Question: In one sentence, what is this figure communicating?
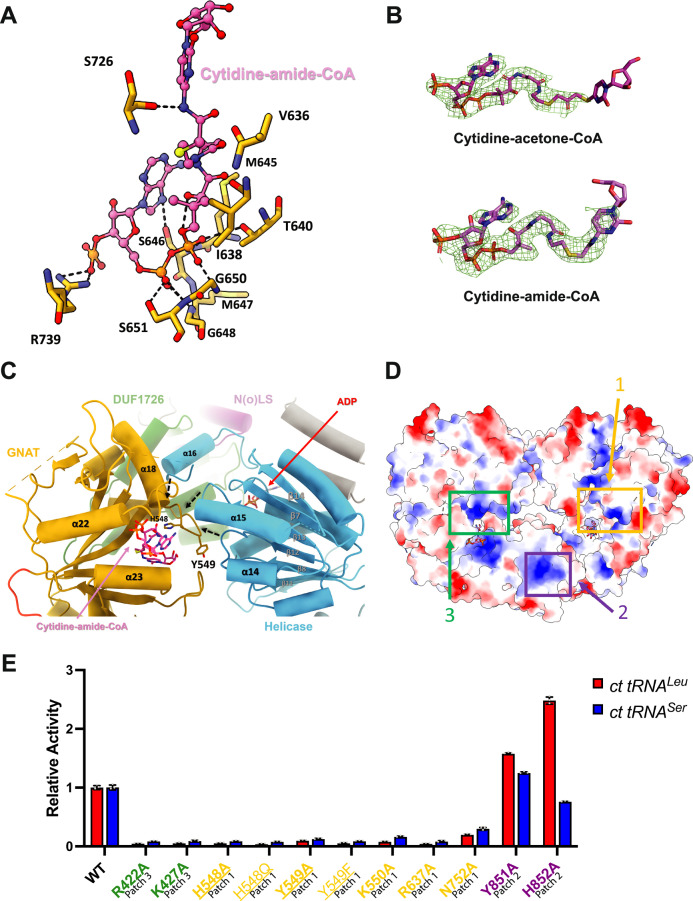
Answer: Acetyl-CoA, Cytidine and RNA binding sites of Ct NAT10. A Close-up view of interactions between Cytidine-amide-CoA and Ct NAT10 protein (figure derived from PDB: 9B0I). Cytidine-amide-CoA (pink) is drawn with ball-and-stick representation and labeled with the same color, and residues that make a hydrogen bond and with Cytidine-amide-CoA are shown by black-colored dashed lines. Van der Waals interaction and hydrophobic interaction are not explicitly shown but described in the main text. Atoms are color-coded as in Fig. 3 . B Cryo-EM density of Cytidine-acetone-CoA (figure derived from PDB: 9AYM) and Cytidine-amide-CoA (figure derived from PDB: 9B0I). Contour levels of 7 σ and 8 σ was shown, respectively. C Putative catalytic residues His548 and Tyr549 (green) within the GNAT domain (gold) are shown proximal to the helicase domain (blue), where movement of the helicase domain can influence positioning of these residues. Bound ADP (red) and Cytidine-amide-CoA (lavender) are drawn as sticks and are labeled with the corresponding color. Dotted black arrows are drawn to suggest how the helicase domain may modulate the positioning of His548 and Tyr549. Figure derived from PDB: 9B0I. D Electrostatic surface diagram of the Ct NAT10 structure (derived from PDB: 9B0I), highlighting 3 color-coded regions (yellow, purple, and green) selected for mutagenesis and functional studies. Neutral, electropositive and electronegative surfaces of the Ct NAT10 structure are colored white, blue and red, respectively. E Relative enzyme activity of Ct NAT10 mutant constructs to wild type (WT). Residues are color-coded according to the regions in Fig. 4D. Putative catalytic residues (His548 and Tyr549) are underlined. Data presented as mean ± standard deviation, n = 3 technical replicates. Individual data points are overlaid as gray dots. Source data are provided as a Source Data file.